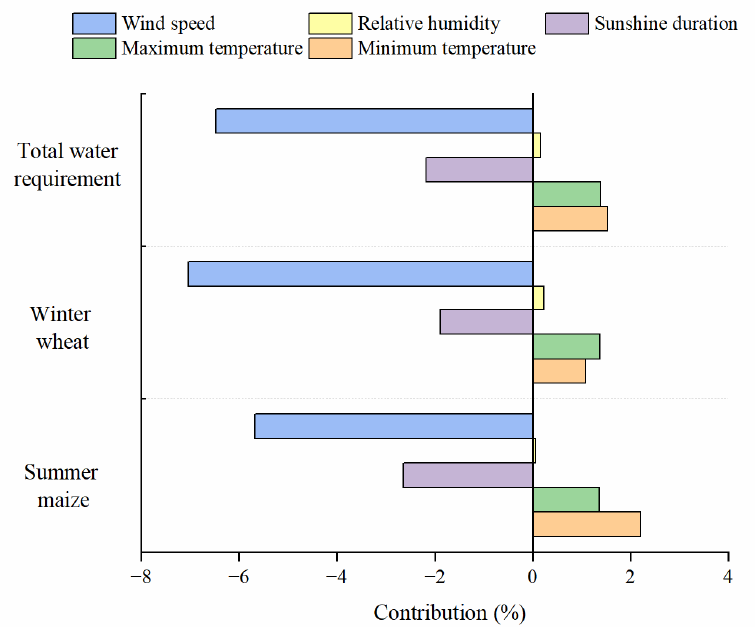
Figure 5. Contribution of meteorological factors to crop water requirement variation in the lower reaches of the Yellow River Basin.